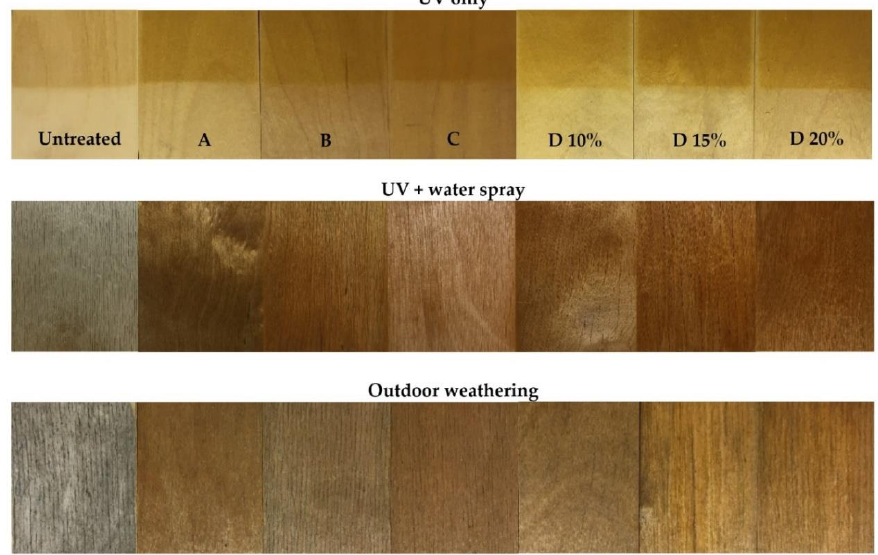
Figure 4. Untreated and PF resin treated plywood photo fixation after weathering with UV only, UV + water spray and in outdoor conditions for 3 months.